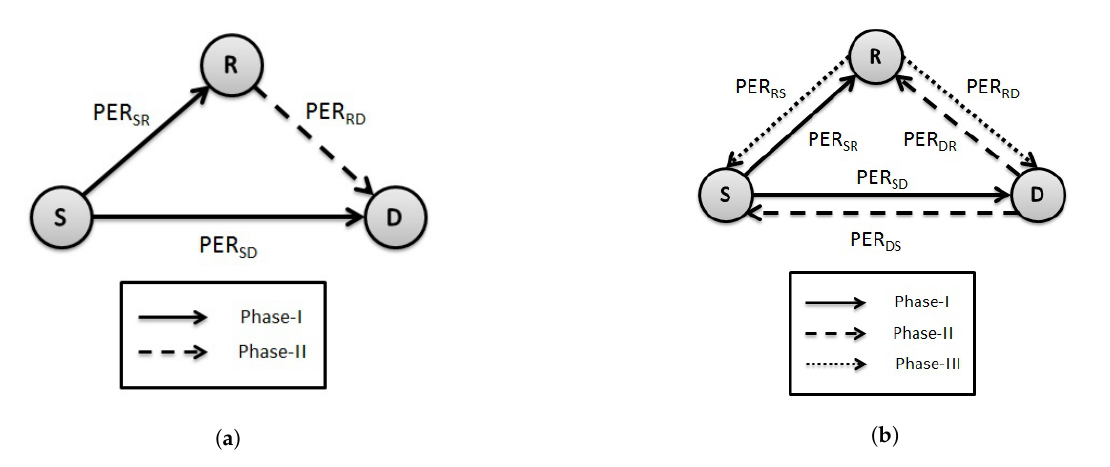
Figure 1. Different communication scenarios using single relay cooperation. ( a ) one-way relay communication; ( b ) two-way relay communication.